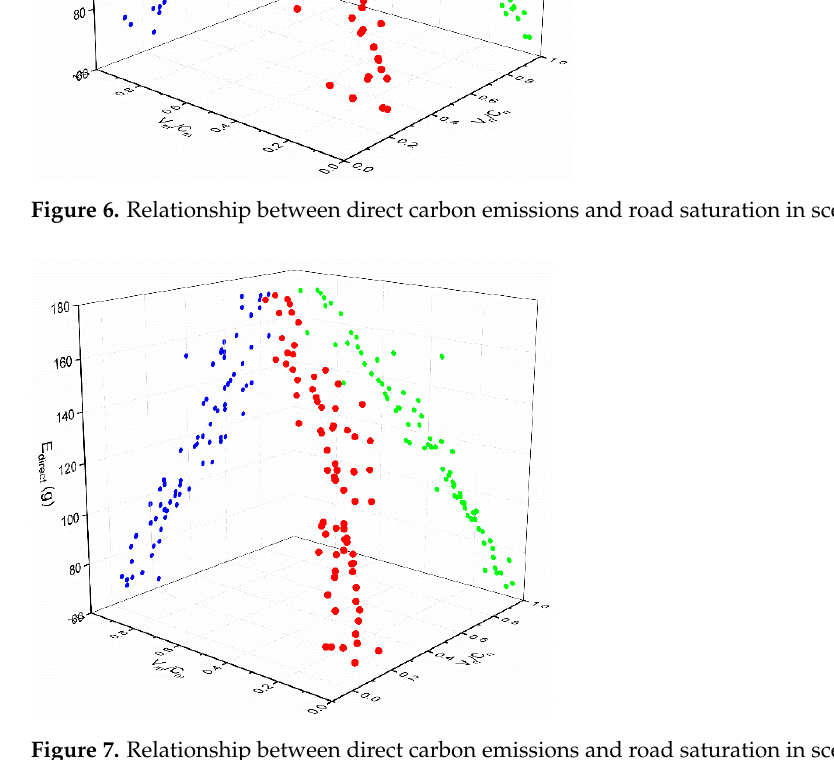
Figure 7. Relationship between direct carbon emissions and road saturation in scenario B2.